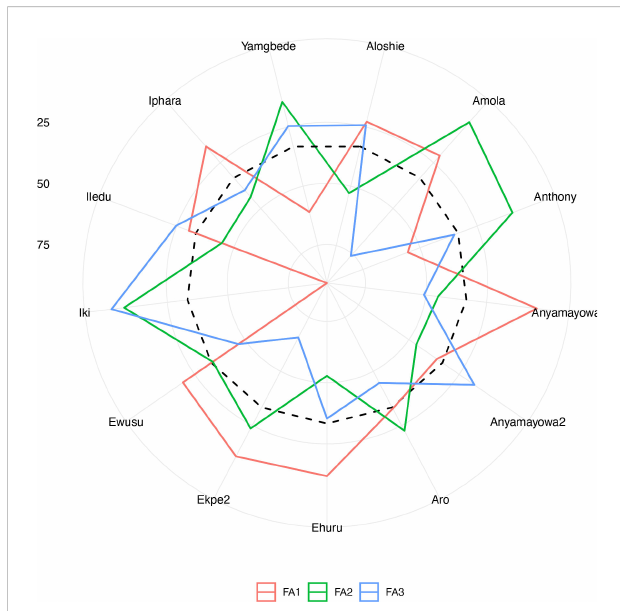
FIGURE 5 Radar chart displaying the strengths and weaknesses of selected Nigerian white Guinea yam landraces based on the FAI ‐ BLUP index. The dashed line shows the theoretical value if all three factors had contributed equally.